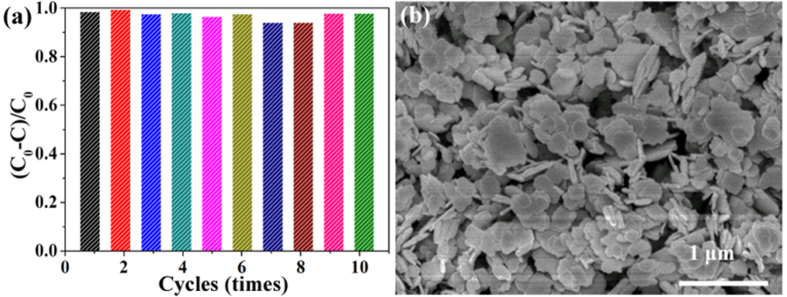
(a) Recycling properties of the BiOBr0.8I0.2 nanoplates; and (b) SEM images of BiOBr0.8I0.2 nanoplates after the photocatalytic reaction.